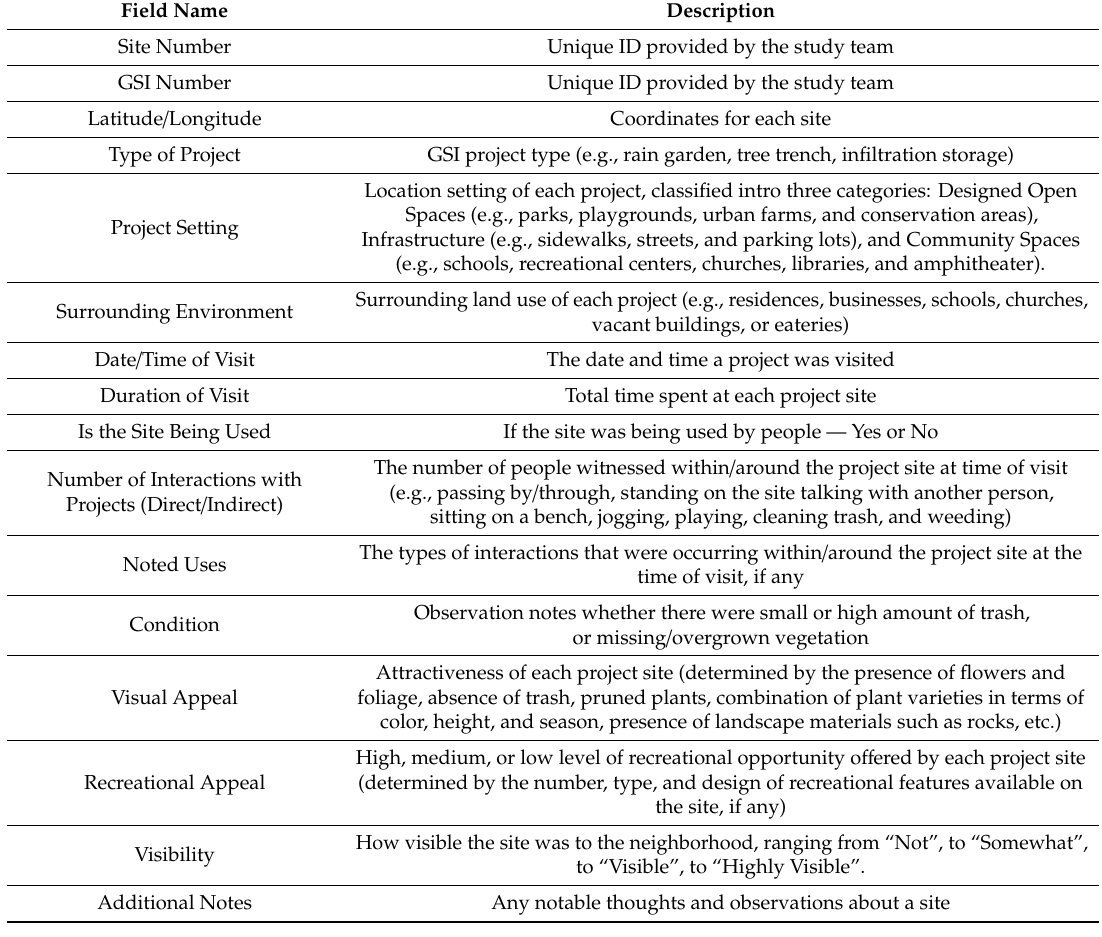
Table 1. Data Fields from Location Analysis Spreadsheet.